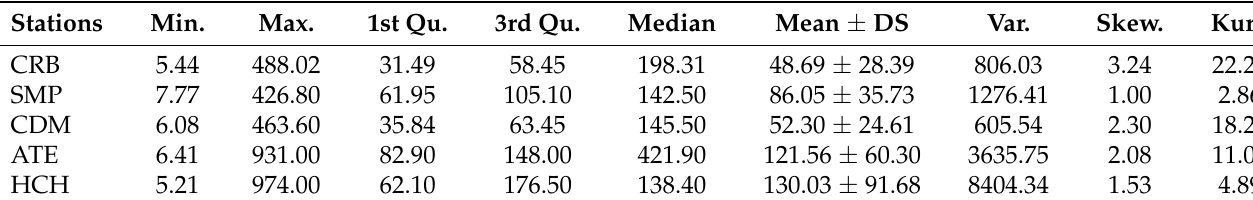
Table 1. Summary statistics - Stations of Monitoring PM 10 .